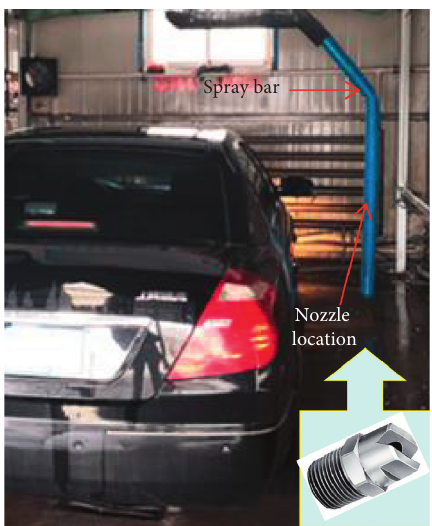
Figure 1: The physical diagram of the side spray bar of an automatic automobile washer.